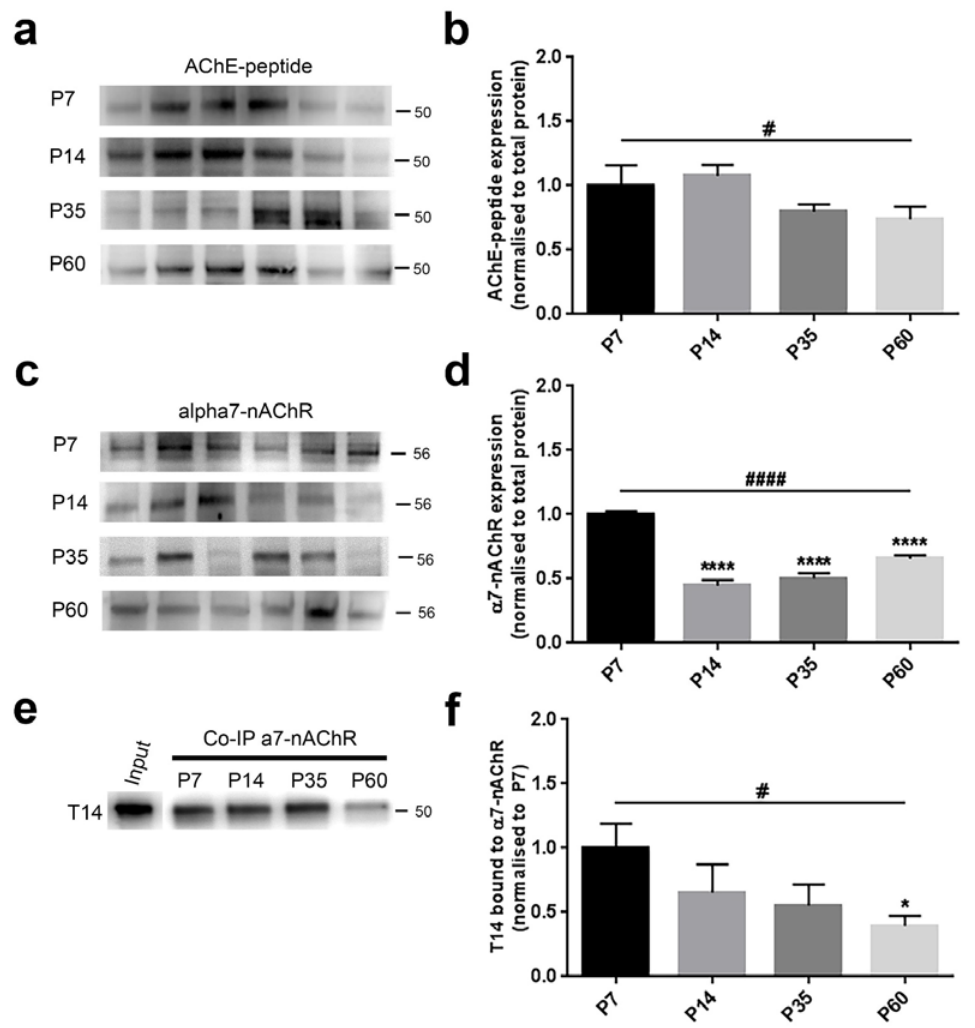
Figure 4. AChE-peptide and α 7-nAChR levels and their interaction showed an age-dependent pattern during postnatal brain development. ( a , c ) Representative immunoblots showing the protein expression in six hemislices from one randomly-chosen animal per age. ( b , d ) Bar graphs indicating the protein profile related to four different ages. ( a , b ) AChE-peptide expression was not significantly affected across ages; however, its levels revealed a decreased tendency from early postnatal to young adult animals (trend analysis post-hoc test). ( c , d ) α7 -nAChR levels were strongly decreased in an age-related manner (trend analysis post-hoc test). In particular, a significant difference was detected when comparing P7 rats to the other groups (Bonferroni’s post-hoc test). ( e ) Representative Co-IP blot showing the molecular interaction between T14 and the nicotinic receptor. ( f ) The complex T14/α7 -nAChR showed a significant decreasing trend across ages (trend analysis post-hoc test) and also a clear change between the two extreme ages (Bonferroni’s post-hoc test). All values are normalised against the P7 group, considered as the control. Asterisks indicate a difference between P7 and the other groups (Bonferroni’s post-hoc test), while hashes represent the linear trend among groups (trend analysis post-hoc test). Data are indicated as the mean ± SEM. n = (hemislices, rats) is (24, 4). * ,# p < 0.05, **** ,#### p < 0.0001.